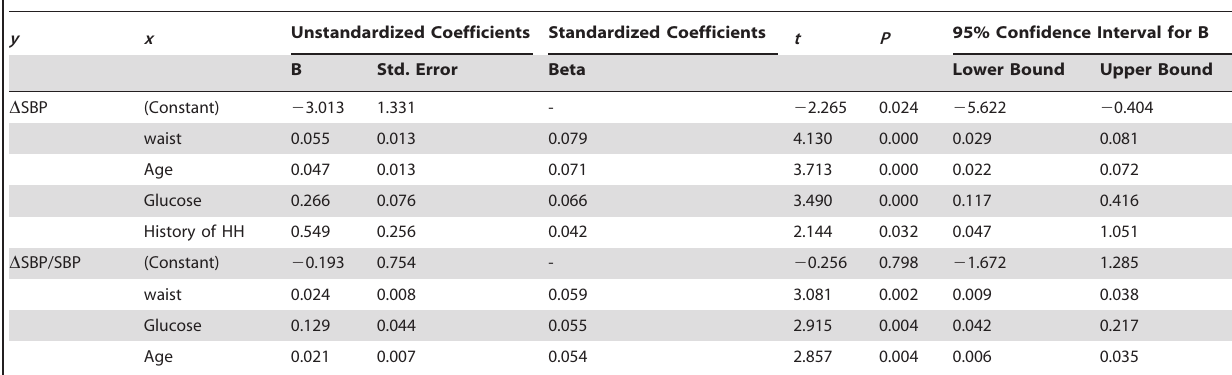
Table 4. The results of multifactor regression analysis.